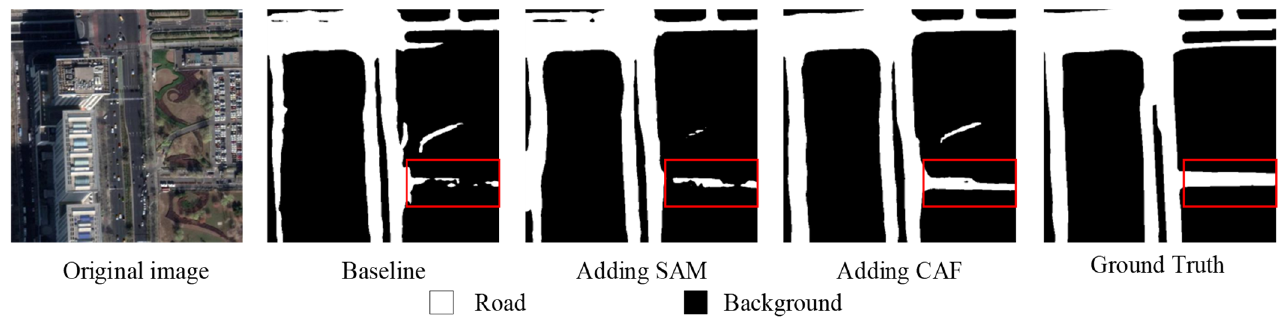
Figure 14. Comparison of visual results of module validity analysis based on CHN6-CUG dataset.